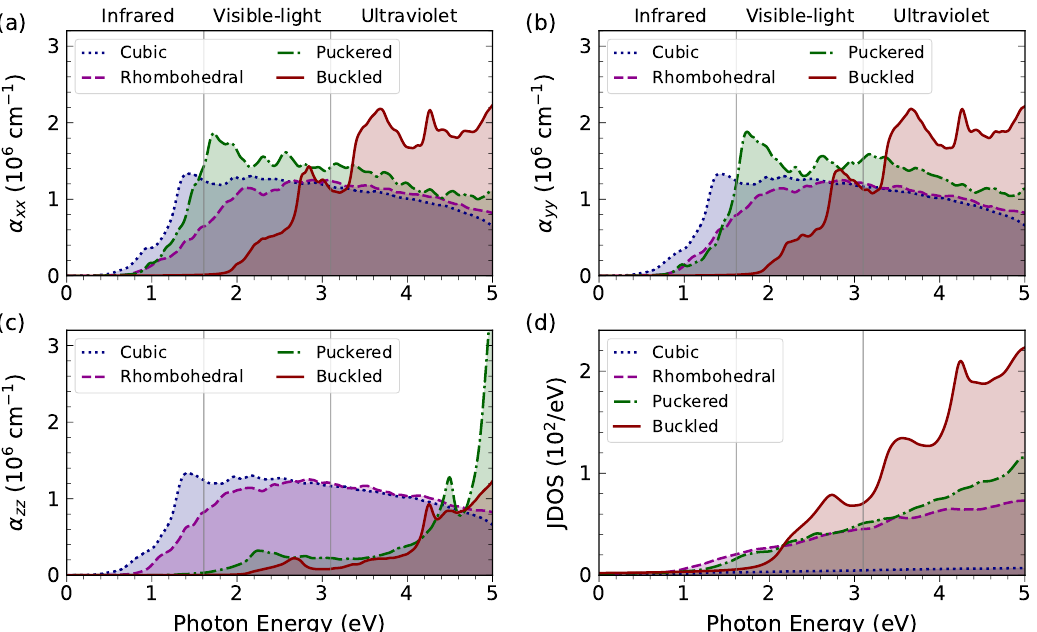
Figure 3. Optical properties of bulk and monolayer GeTe. Panels ( a – c ) give the absorption coefficients for light polarization along the x -, y -, and z -axes. Panel ( d ) shows the joint density of states. Two vertical lines at 1.61 eV and 3.10 are the borders of the visible-light regime. Below 1.61 eV (above 3.10 eV) is the infrared (ultraviolet)